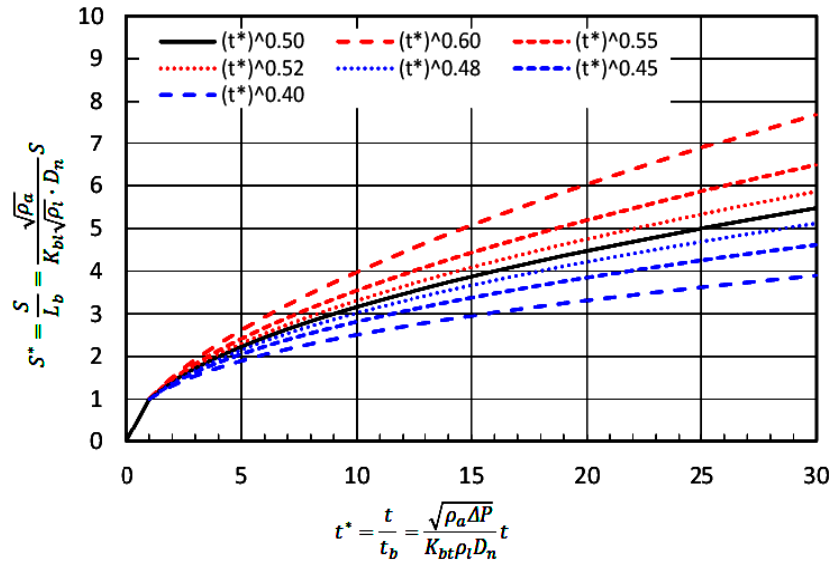
Figure 10. General behavior of non-dimensional spray penetration changing with exponential index n .